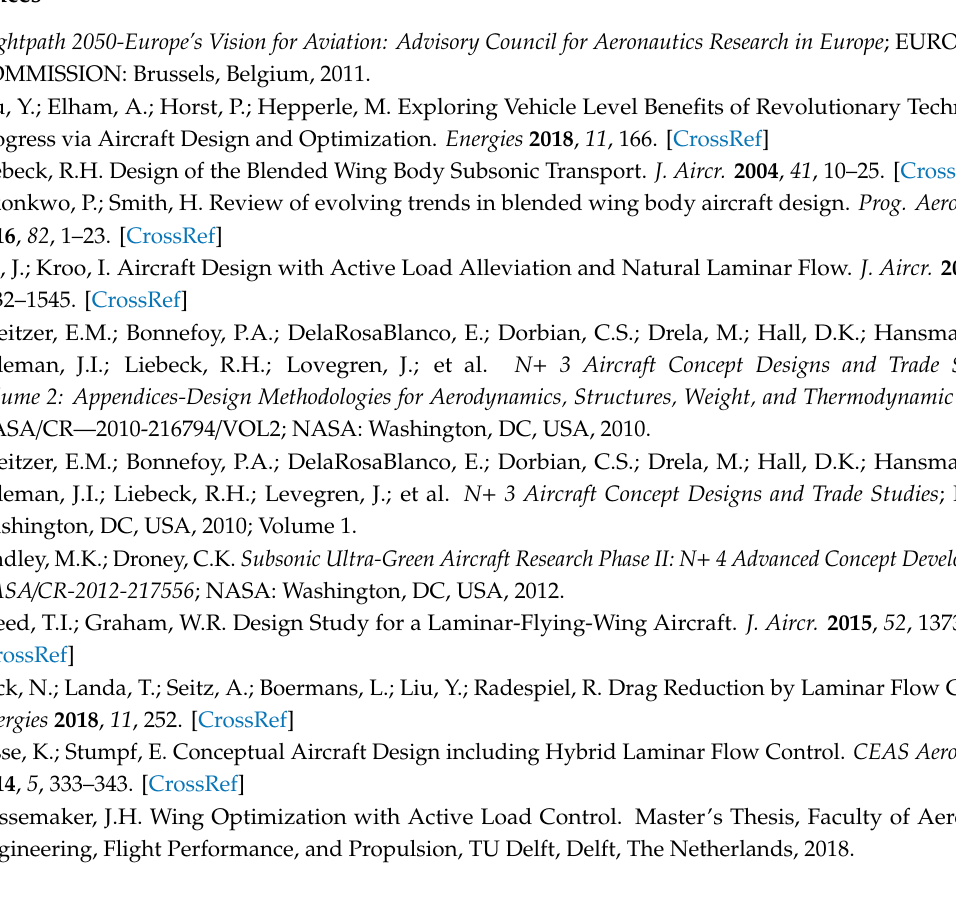
Figure A17. Pressure coefficients for RANS and Euler simulations at AoA = 2 deg.